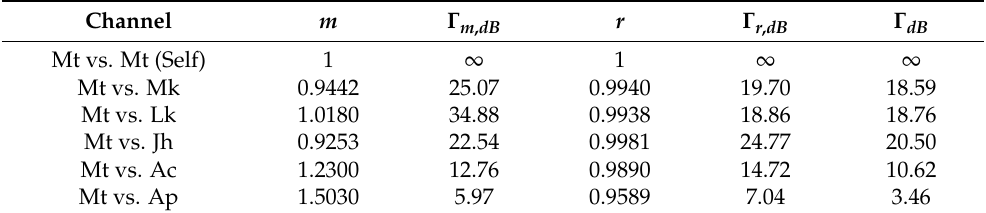
Table 3. Values of m –calculated with Equation (4)-and r –calculated with Equation (8)–and the total signal-to-noise ratio Γ dB calculated with Equations (11) and (12), and the partial values Γ m , dB and Γ r , dB , calculated with Equations (6) (7), (9) and (10) in the indicated cross-channels. Channel m Γ m , dB r Γ r , dB Γ dB Mt vs. Mt (Self) 1 ∞ 1 ∞ ∞ Mt vs. Mk 0.9442 25.07 0.9940 19.70 18.59 Mt vs. Lk 1.0180 34.88 0.9938 18.76 Mt vs. Jh 0.9253 Mt vs. Ac 1.2300 12.76 10.62 Mt vs. Ap 1.5030 0.9589